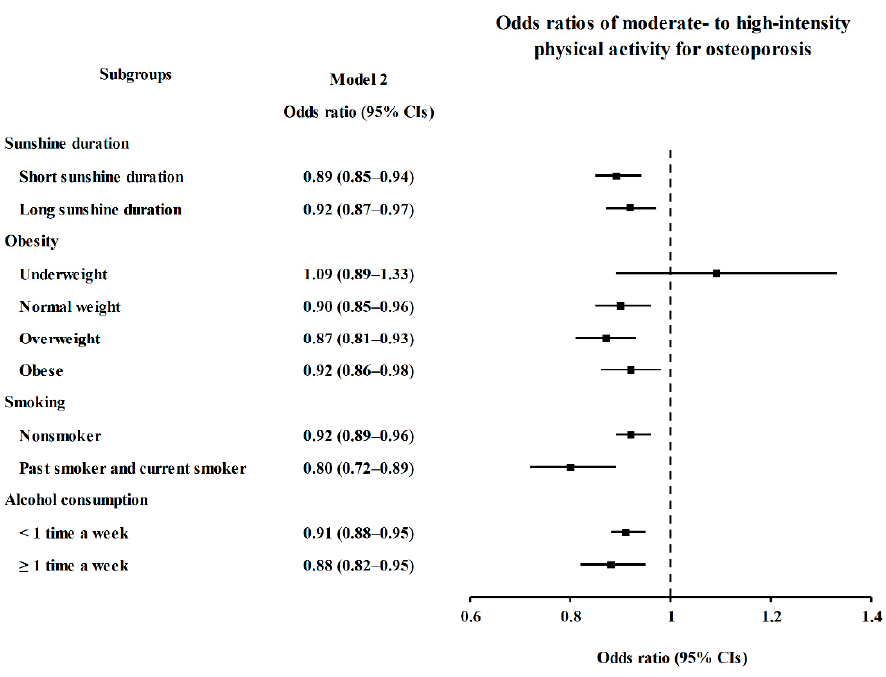
Figure 2. Subgroup Analyses of Moderate- to High-Intensity Physical Activity for Osteoporosis According to Sunshine Duration, Obesity, Smoking, and Alcohol Consumption Visualized by For- est Plot.